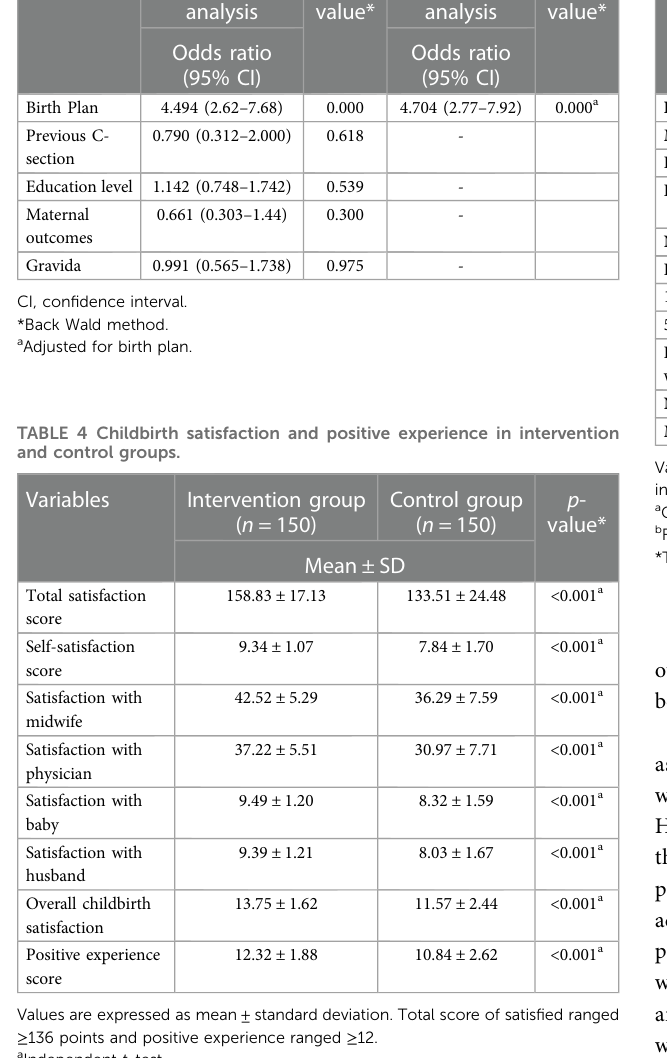
TABLE 3 The unadjusted and adjusted odds ratios for variables related to normal vaginal birth. Variables